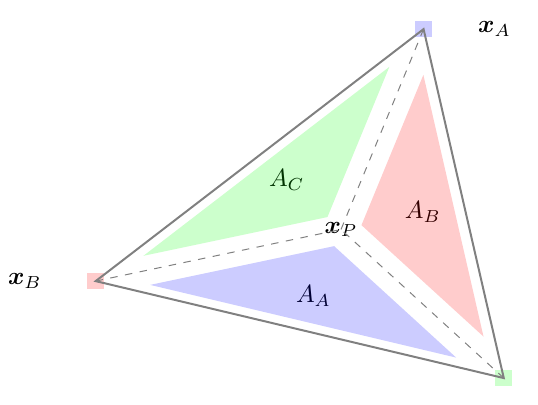
Figure 6: Let x A , x B and x C be the position vectors of the blue, red and green vertices of the triangle, respectively. The position of any point x P on the triangle is given by x P = , λ A x A + λ B x B + λ C x C , where λ A = A A A λ A = A B , and λ C = A C . A A , A B , A C are A A the areas of the blue, red and green subtri- angles, respectively, and A is the total area of the triangle such that A = A A + A B + A C